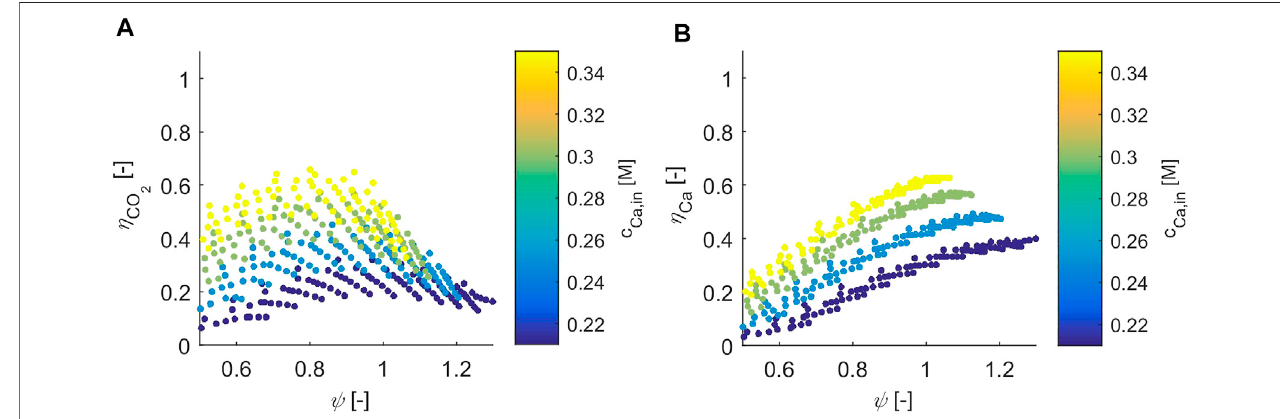
FIGURE 4 | The CO 2 capture ef fi ciency (subplot (A) ) and the calcium precipitation ef fi ciency (subplot (B) ) are plotted as a function of ψ . The colors indicate the calcium concentration, read out at the color bar. (A) CO 2 capture ef fi ciency. (B) Ca precipitation ef fi ciency.